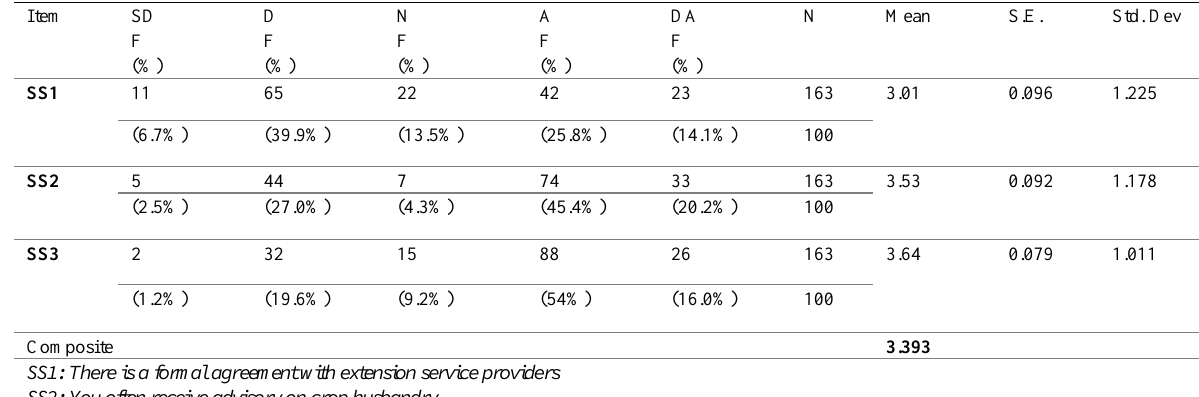
Table 1: Access to extension services and Sustainability of DFLPs